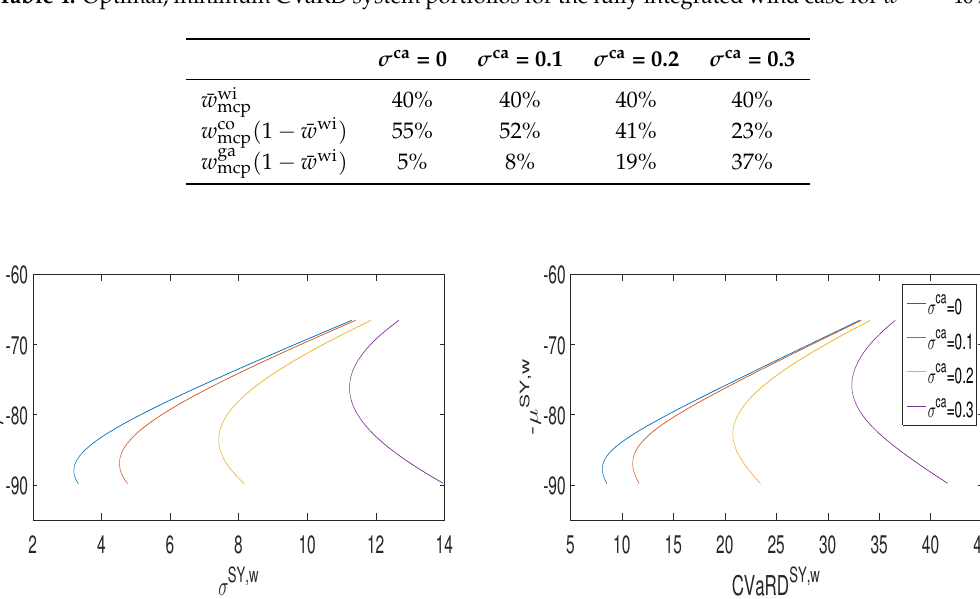
Table 4. Optimal, minimum CVaRD system portfolios for the fully integrated wind case for ¯ w wi = 40%.